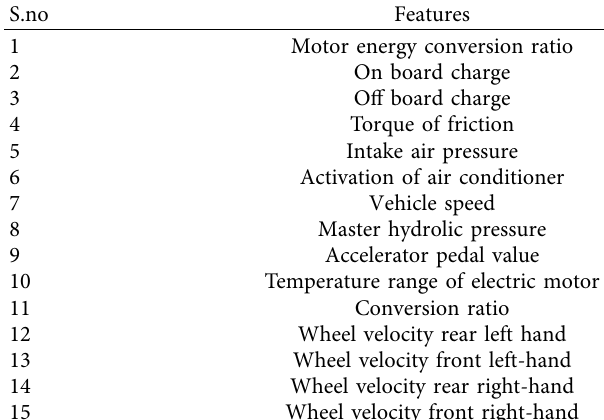
Table 1: Selected